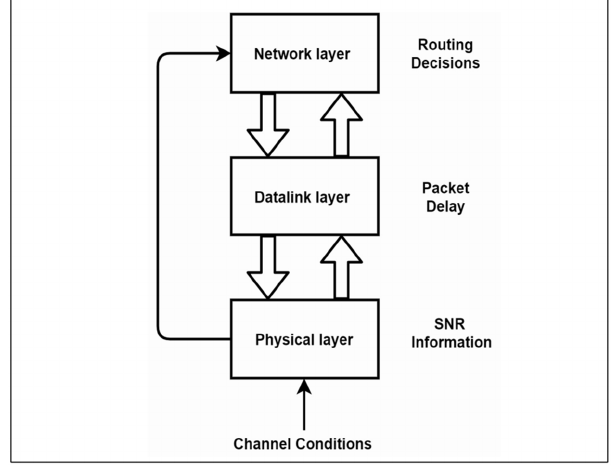
Figure 3. Conceptual design of cross-layer network.